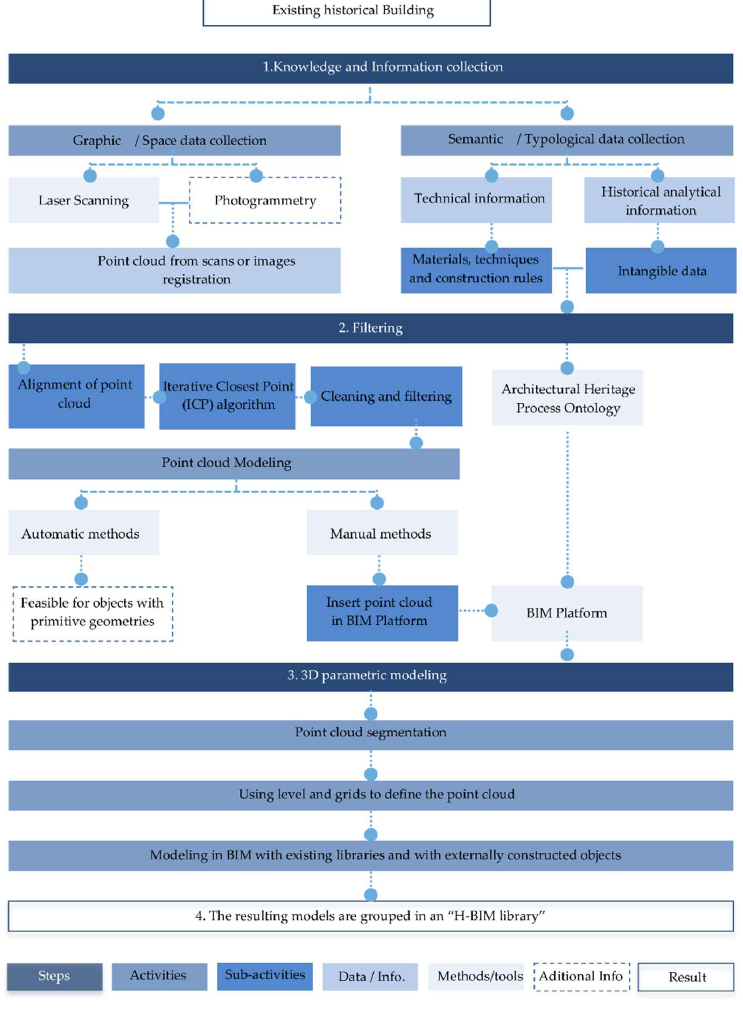
Figure 4. This flow diagram describes the manual construction method of the Heritage Building Information Modeling (H-BIM) library. There are other methods, but they have not been reflected. Source: Own